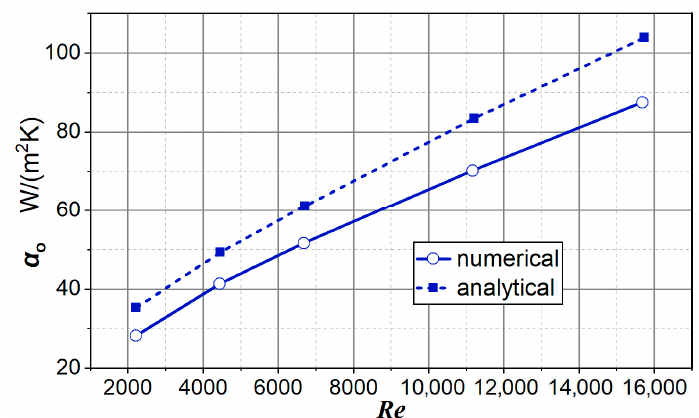
Figure 18. Convective heat transfer coefficient based on numerical analysis data and analytical calculation.